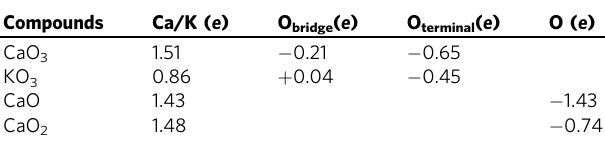
Table 1 Bader charge analysis of CaO 3 , KO 3 , CaO, and CaO 2 at 30